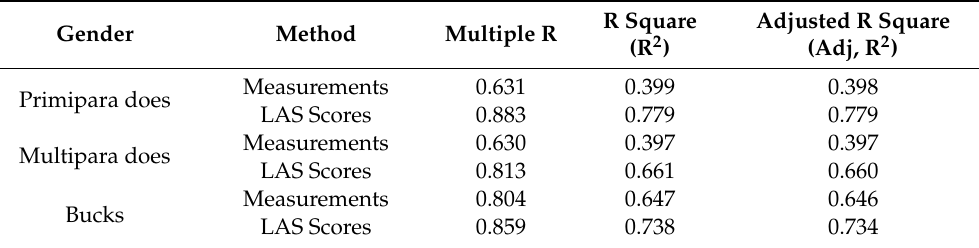
Table 7. β -standardized coe ffi cients to replace the Z score in each of the respective equations in Supplementary Table S5 and a 0.632 bootstrap mean squared error of prediction (MSEP) for the comparison of model validity between the two linear regression models using linear appraisal traits as opposed to Murciano-Granadina zoometric traditional assessment in does and